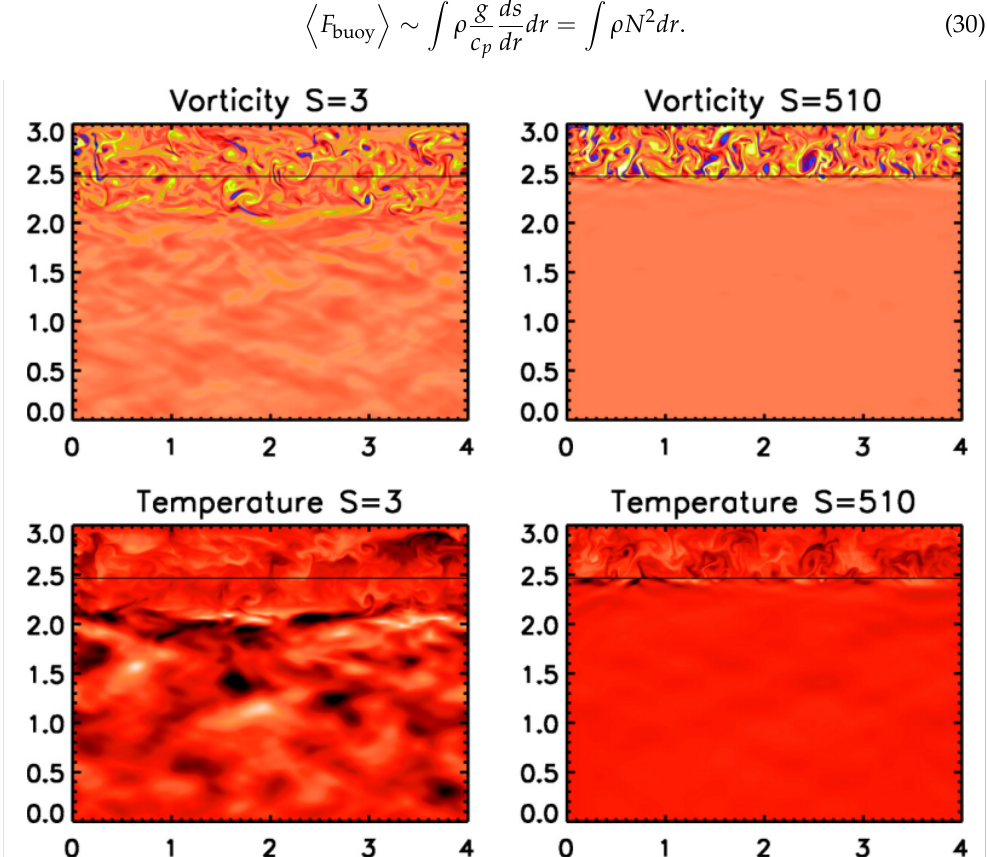
Figure 5. The vorticity (top) and temperature (bottom) are shown for simulations whose values of are small (left) and large (right). The black line marks the Schwarzschild boundary of the S struct simulations. Note that increasing decreases the depth to which dynamics overshoot beyond the S Schwarzschild boundary. Note also that as stiffness increases, the internal gravity wave amplitude in the stable region decreases with respect to the convection amplitude. Figure 2 of Rogers and Glatzmaier [120]; © AAS. Reproduced with